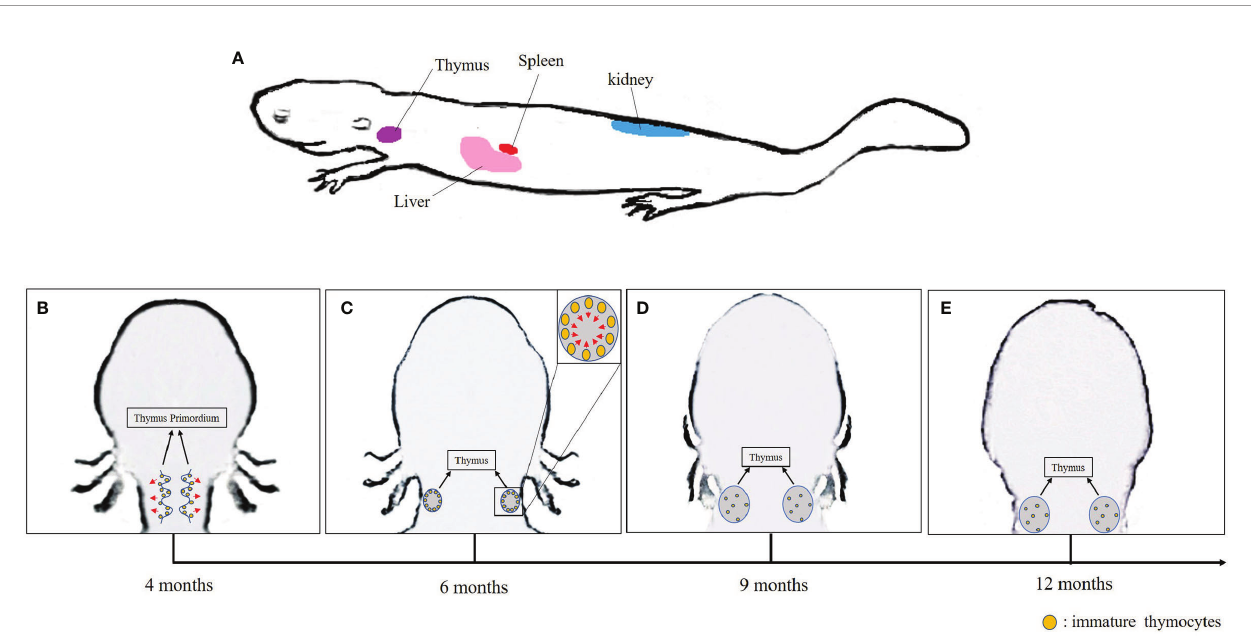
FIGURE 1 | (A) Lymphopoietic tissues in Chinese giant salamander. (B – E) Schematic overview of the thymus development in the Chinese giant salamander. Arrows indicate the direction of migration of immature